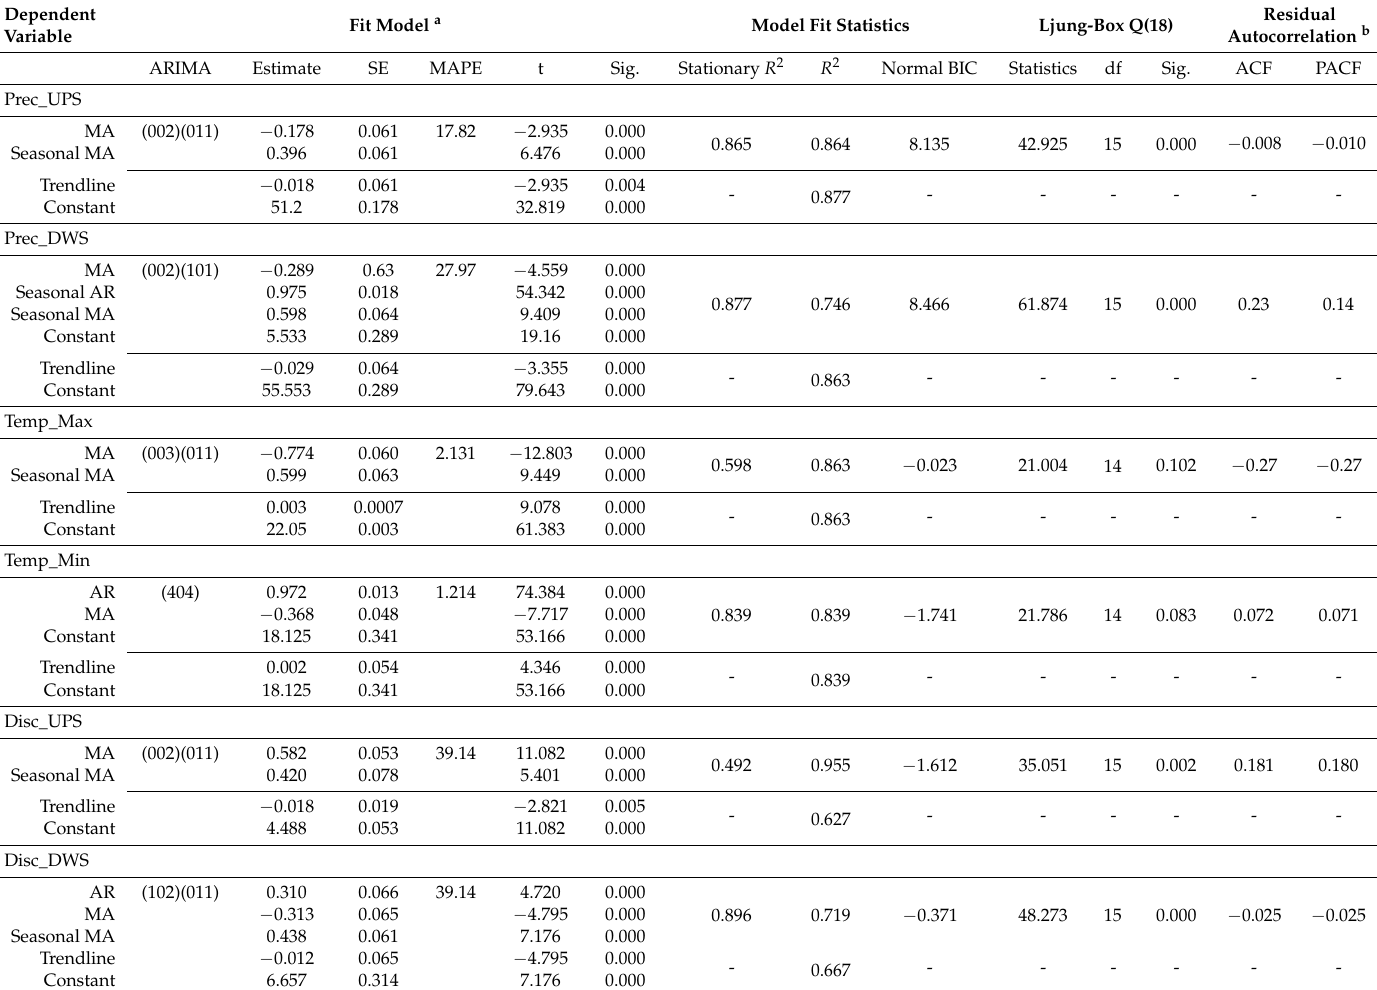
Table 1. Seasonal hydro-climatic forecast for the upper and lower Muooni